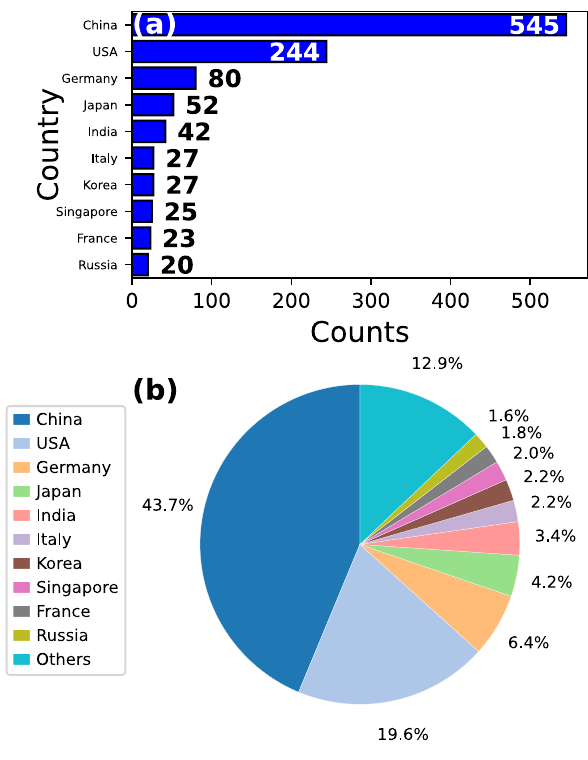
Fig. 5 a Top ten countries in contributions on studies of MGs using MD simulations. b Percentage distribution per country. The “Others” wedge is composed by 27 countries with less than 20 articles